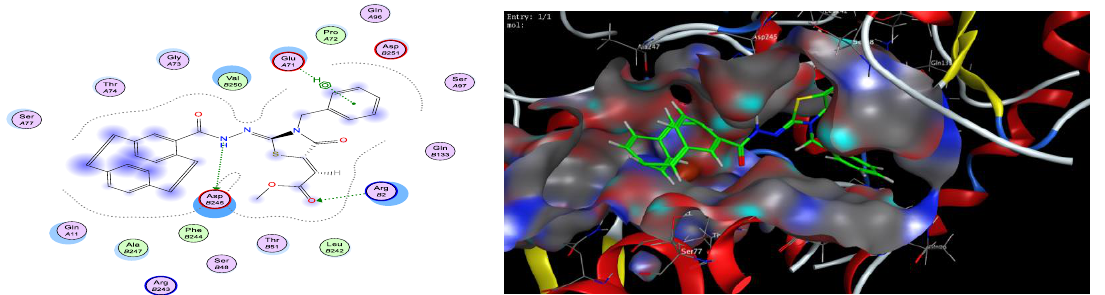
Figure 17. The 2D and 3D diagrams illustrate the binding mode of 3b interacting with the colchicine binding site of β-tubulin.